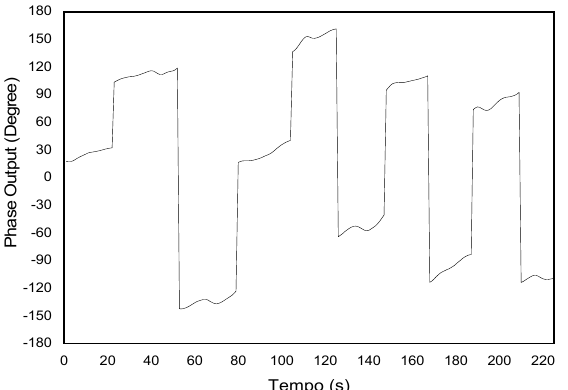
Figure 10. Lock-in output signal proportional to the interferometric phase variation.